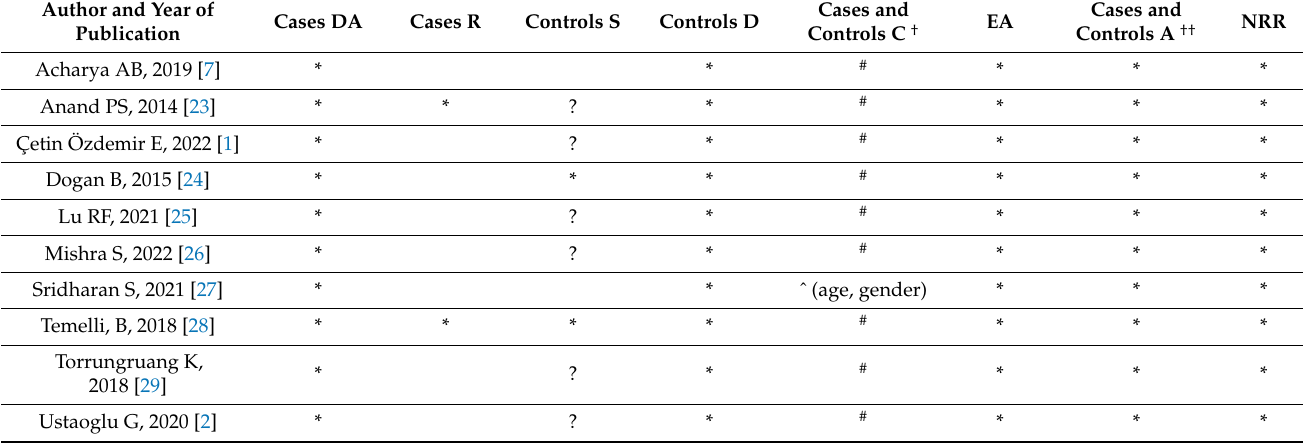
Table 2. Newcastle Ottawa Scale quality assessment of the selected articles.